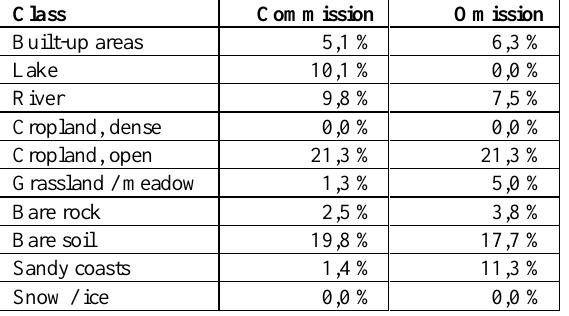
Table 4. Errors of commission and omission for each class (Standard error)